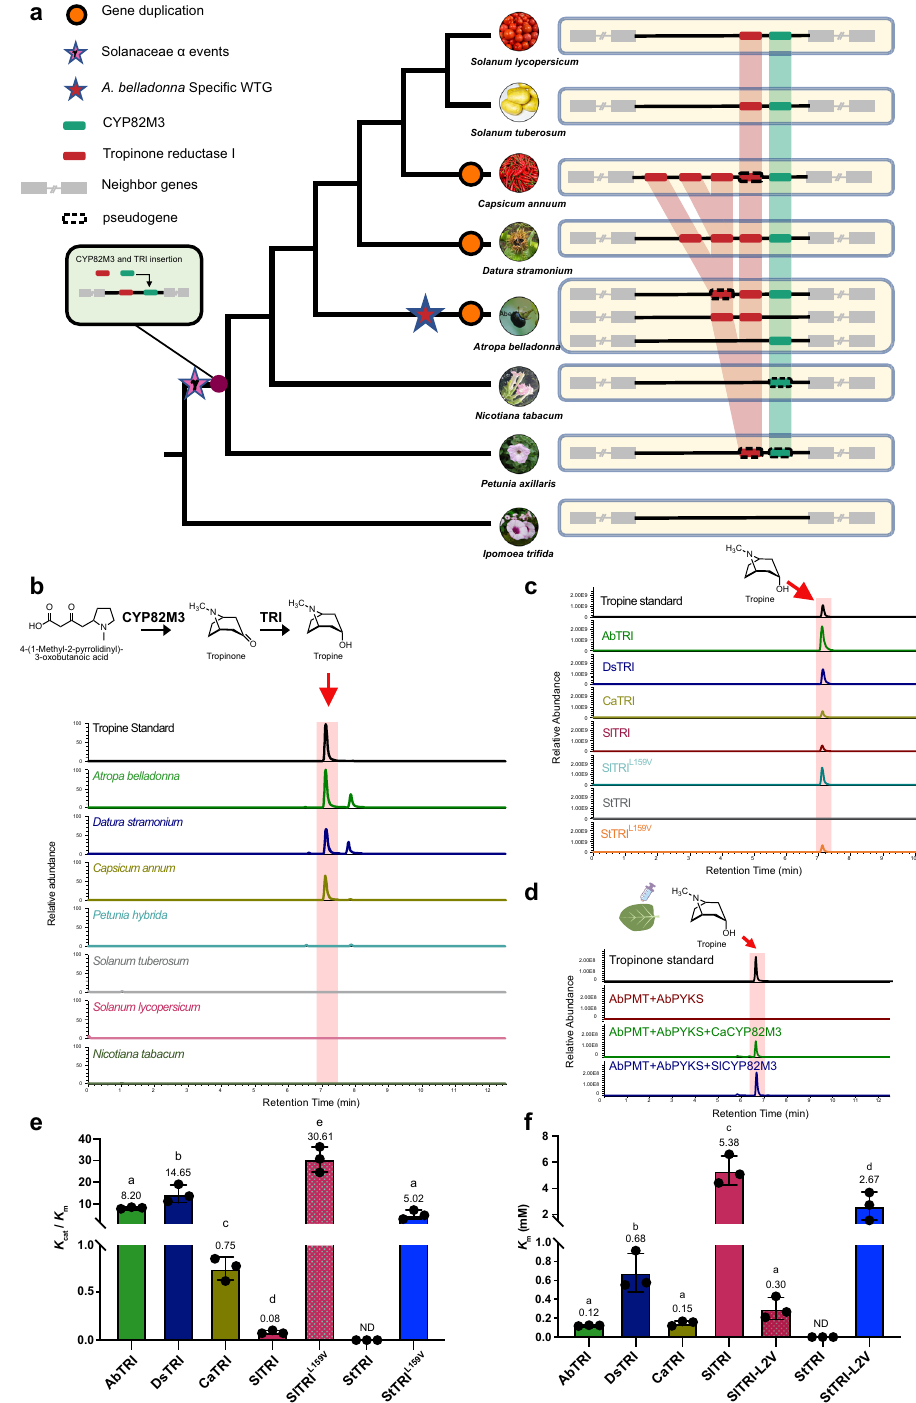
Fig. 4 | The evolution of the tropine gene cluster is associated with tropine diversity across the Solanaceae family. a The tropine gene cluster syntenic regions of seven Solanaceae species and the outgroup species Ipomea tri fi da (Convolvulaceae).GenesencodingTRIareindicatedintheredrectangle,andgenes encoding CYP82M3 are indicated in the green rectangle. b Analysis of tropine in plantsbycombinedLC/MS.Theroots,stemsandleavesofplantswereanalyzedfor the detection of tropine. The extracted ion chromatograms of tropine are high- lightedinred. c Extractedionchromatogramsshowingtheinvitroactivityofseven puri fi ed recombinant TRIs from A . belladonna (AbTRI), D . stramonium (DsTRI), C . annuum (CaTRI), S . lycopersicum (SlTRI), S . tubersoum (StTRI), SlTRI L169V , and